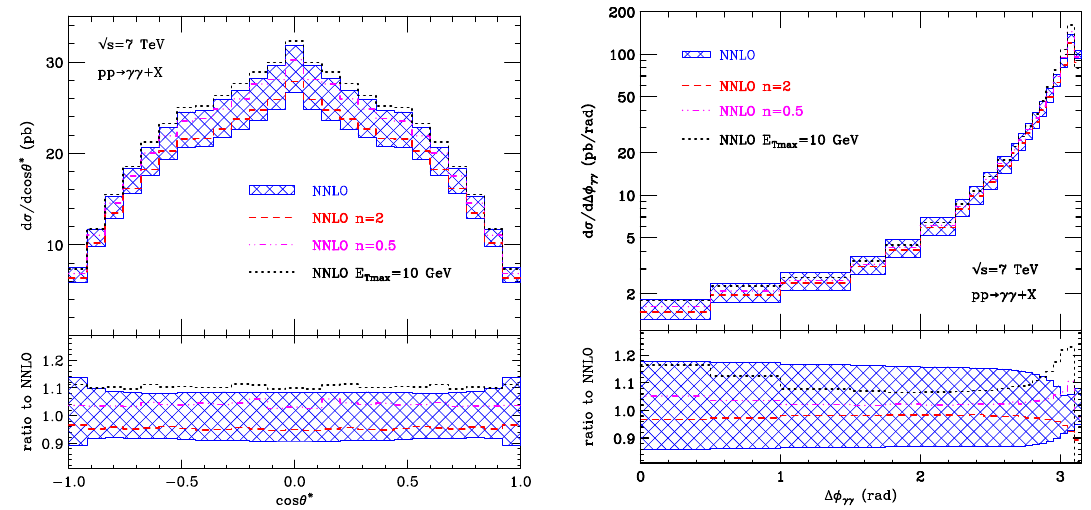
Figure 16 . Isolation parameter dependence of dσ/d cos θ ∗ (left) and dσ/d ∆Φ γγ (right) at NNLO. The reference results (including their scale dependence) with n = 1 and E T max = 4 GeV of figures 12 and 13 are compared to corresponding results that are obtained by varying either n ( n = 2 and n = 0 . 5) or E T max ( E T max = 10 GeV). Cross sections ratios with respect to the reference result are shown in the lower